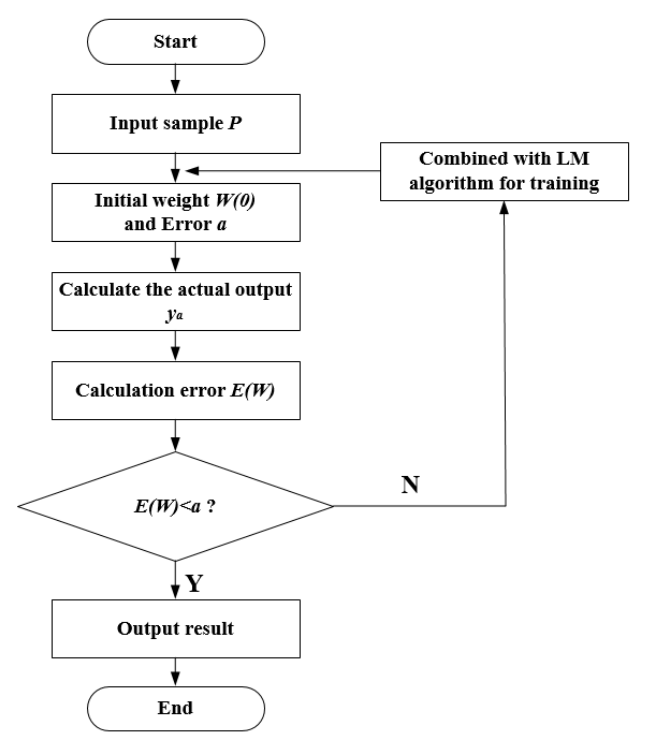
Figure 6. The flowchart of the Levenberg–Marquardt (LM) algorithm to improve the back-propagation (BP) neural network.